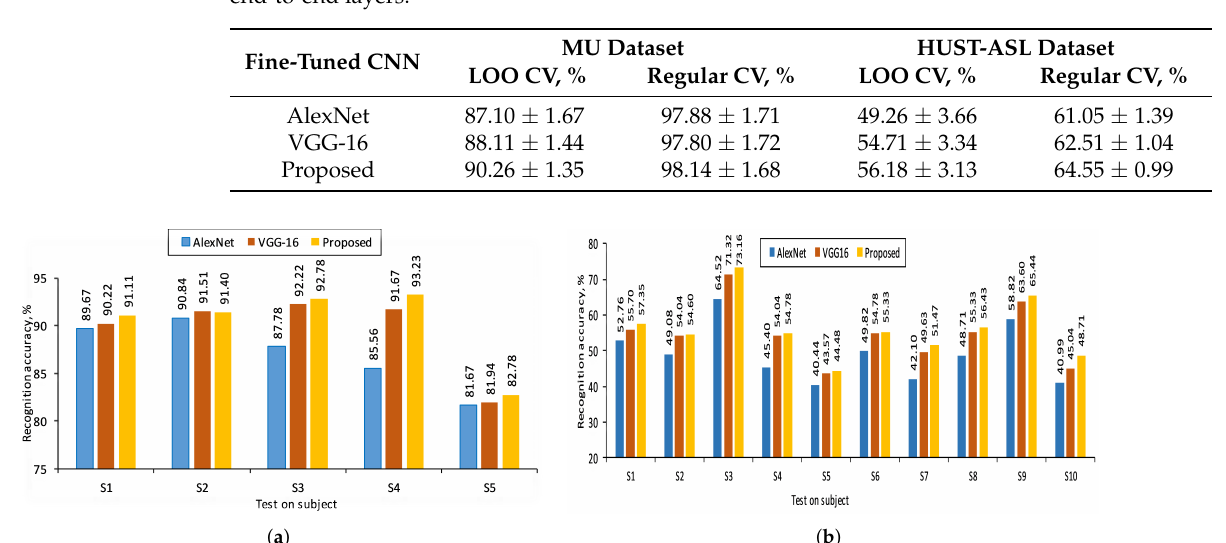
Table 2. Comparison results of mean accuracy with fine-tuned CNNs and score fusion for both CV tests on two standard datasets. Both the weight and bias of the pre-trained CNNs are fine-tuned for end-to-end layers.